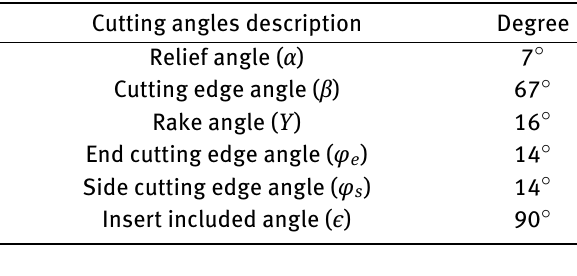
Table 8: Cutting angles setup.